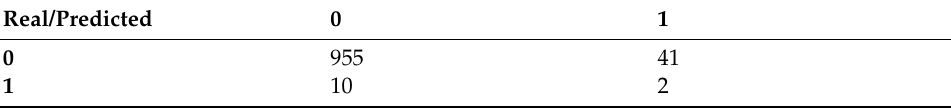
Table 6. Confusion Matrix (KNN).